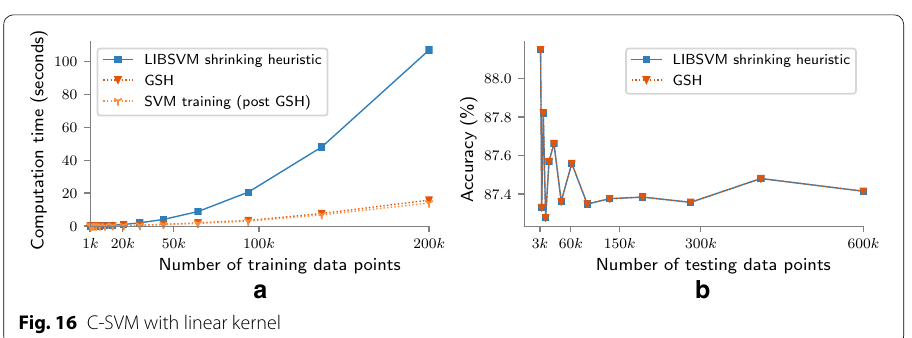
Fig. 16 C-SVM with linear